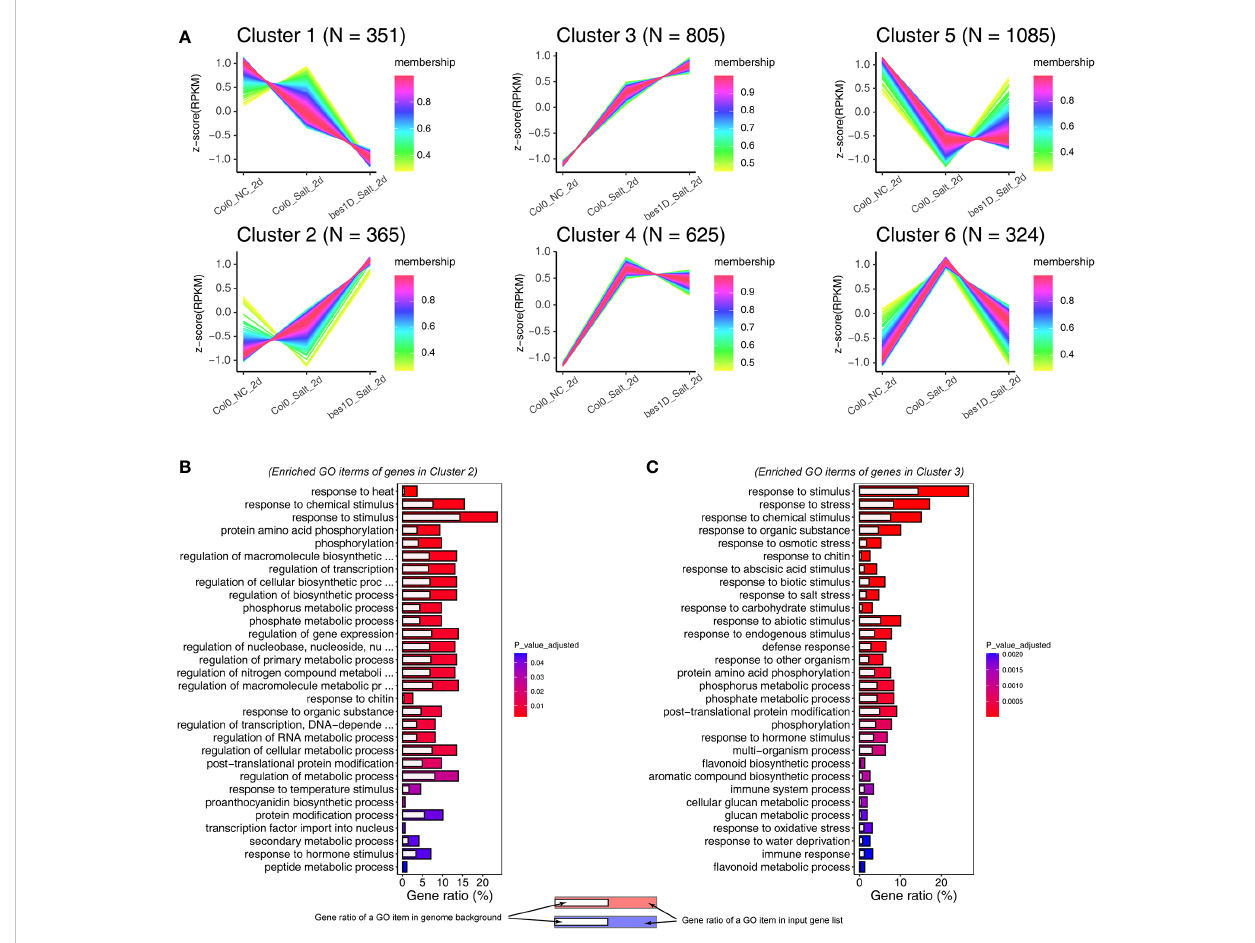
FIGURE 4 Time Series Clustering analyses of genes in bes1-D and Col-0 under salt stress. (A) Fuzzy c-means algorithm was used for clustering. Gene expression was normalized by Z-score transformation. (B) Gene Ontology analysis for 365 genes in cluster 2. (C) Gene Ontology analysis for 805 genes in cluster 3. Only top 30 Biological Process items were showed in (B, C) due to the space